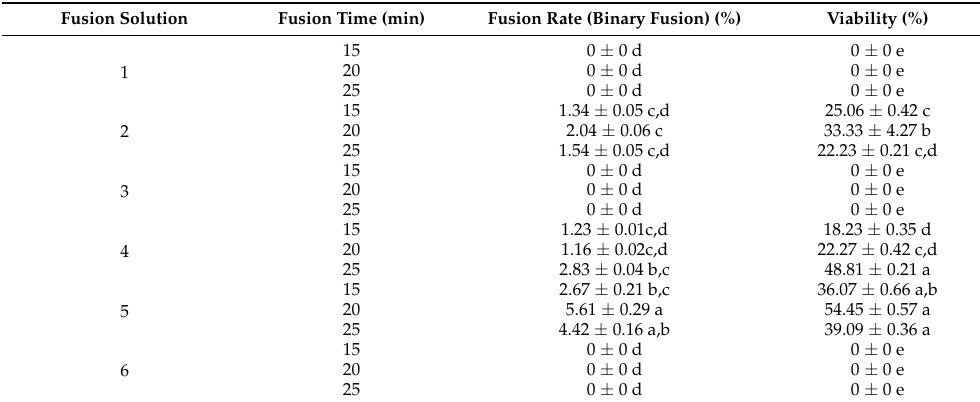
Table 5. Effect of different fusion solution and fusion time on protoplast fusion frequency (%) between J. sambac L. and J. mesnyi.